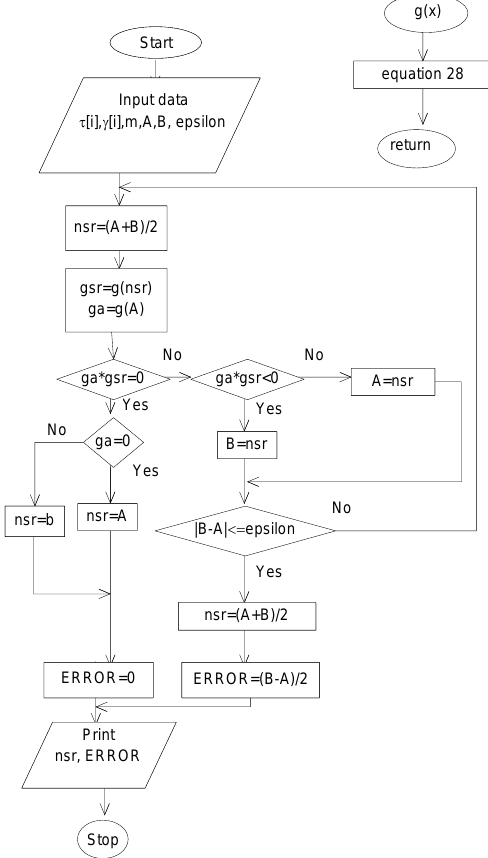
Figure 2. Flow chart for the calculation of the root of the g ( n ) function within the interval [A, B] by means of the bisection method.